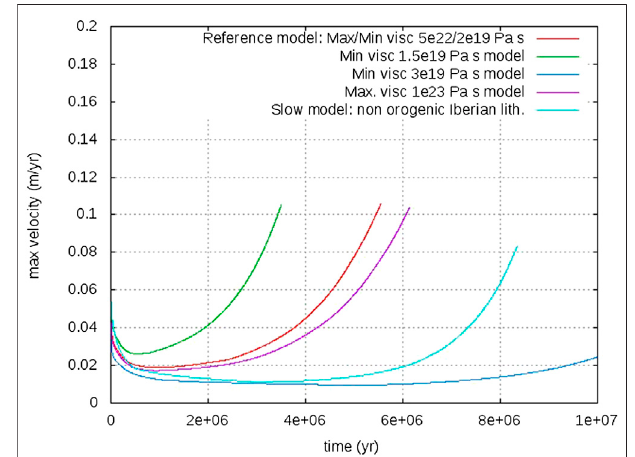
FIGURE 8 | Sensitivity study showing the evolution of maximum velocities of different simulations. Acceleration of maximum velocities indicate the transition from stable to unstable delamination. Only the viscosity cutoffs are varied with respect to the Reference Model (red line), except for the “ Slow Model, ” which considers a 20 km thinner Iberian lithosphere and a minimum viscosity cutoff 10 19 Pa ·